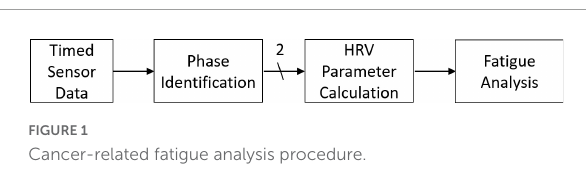
FIGURE1 Cancer-related fatigue analysis